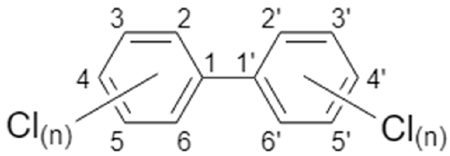
Figure 1. Basic PCB chemical structure. DL PCB congeners are typically meta (3, 3 ′ , 5, 5 ′ ) and para (4, 4 ′ ) substituted, with no chlorines at the ortho positions (2, 2 ′ , 6, 6 ′ ), and are coplanar. NDL PCBs typically have more than one ortho -substituted chlorine and adopt a non-coplanar structure.